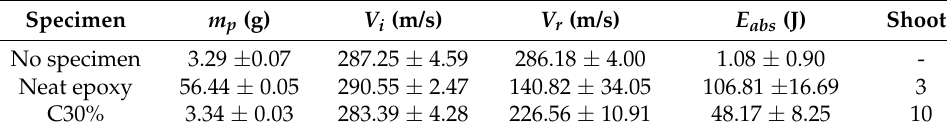
Table 5. Absorption energy in ballistic testing of a 30 vol% fiber composite sample.